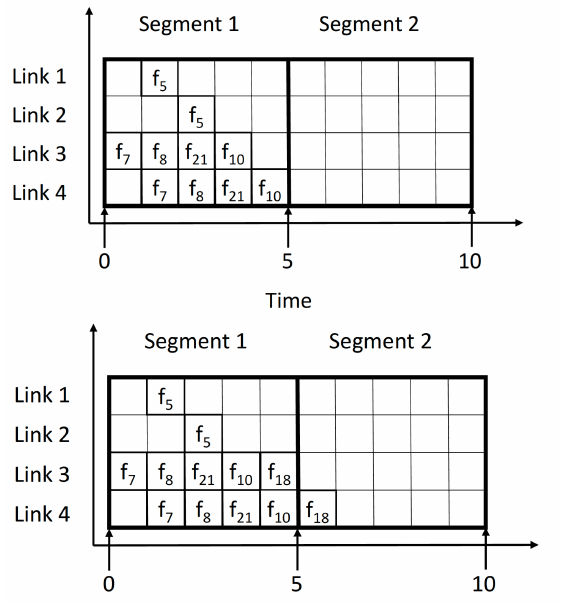
Figure 4. Example of frame scheduled with relaxed